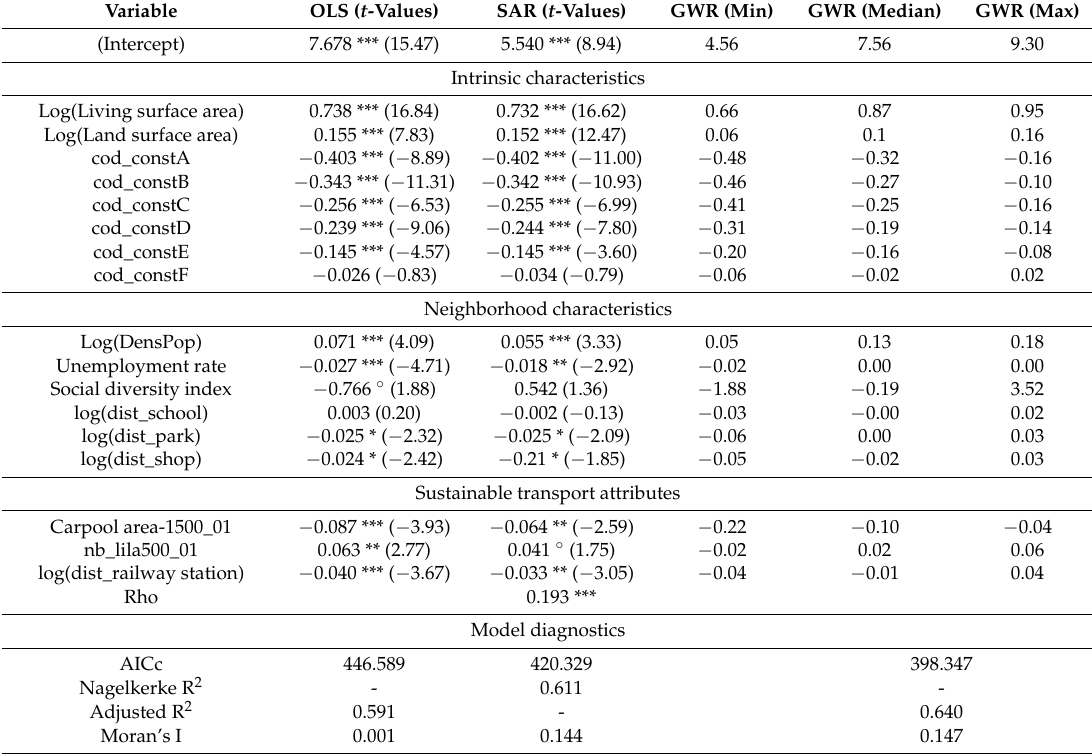
Table 4. Results of estimations for periurban and rural areas ( n =